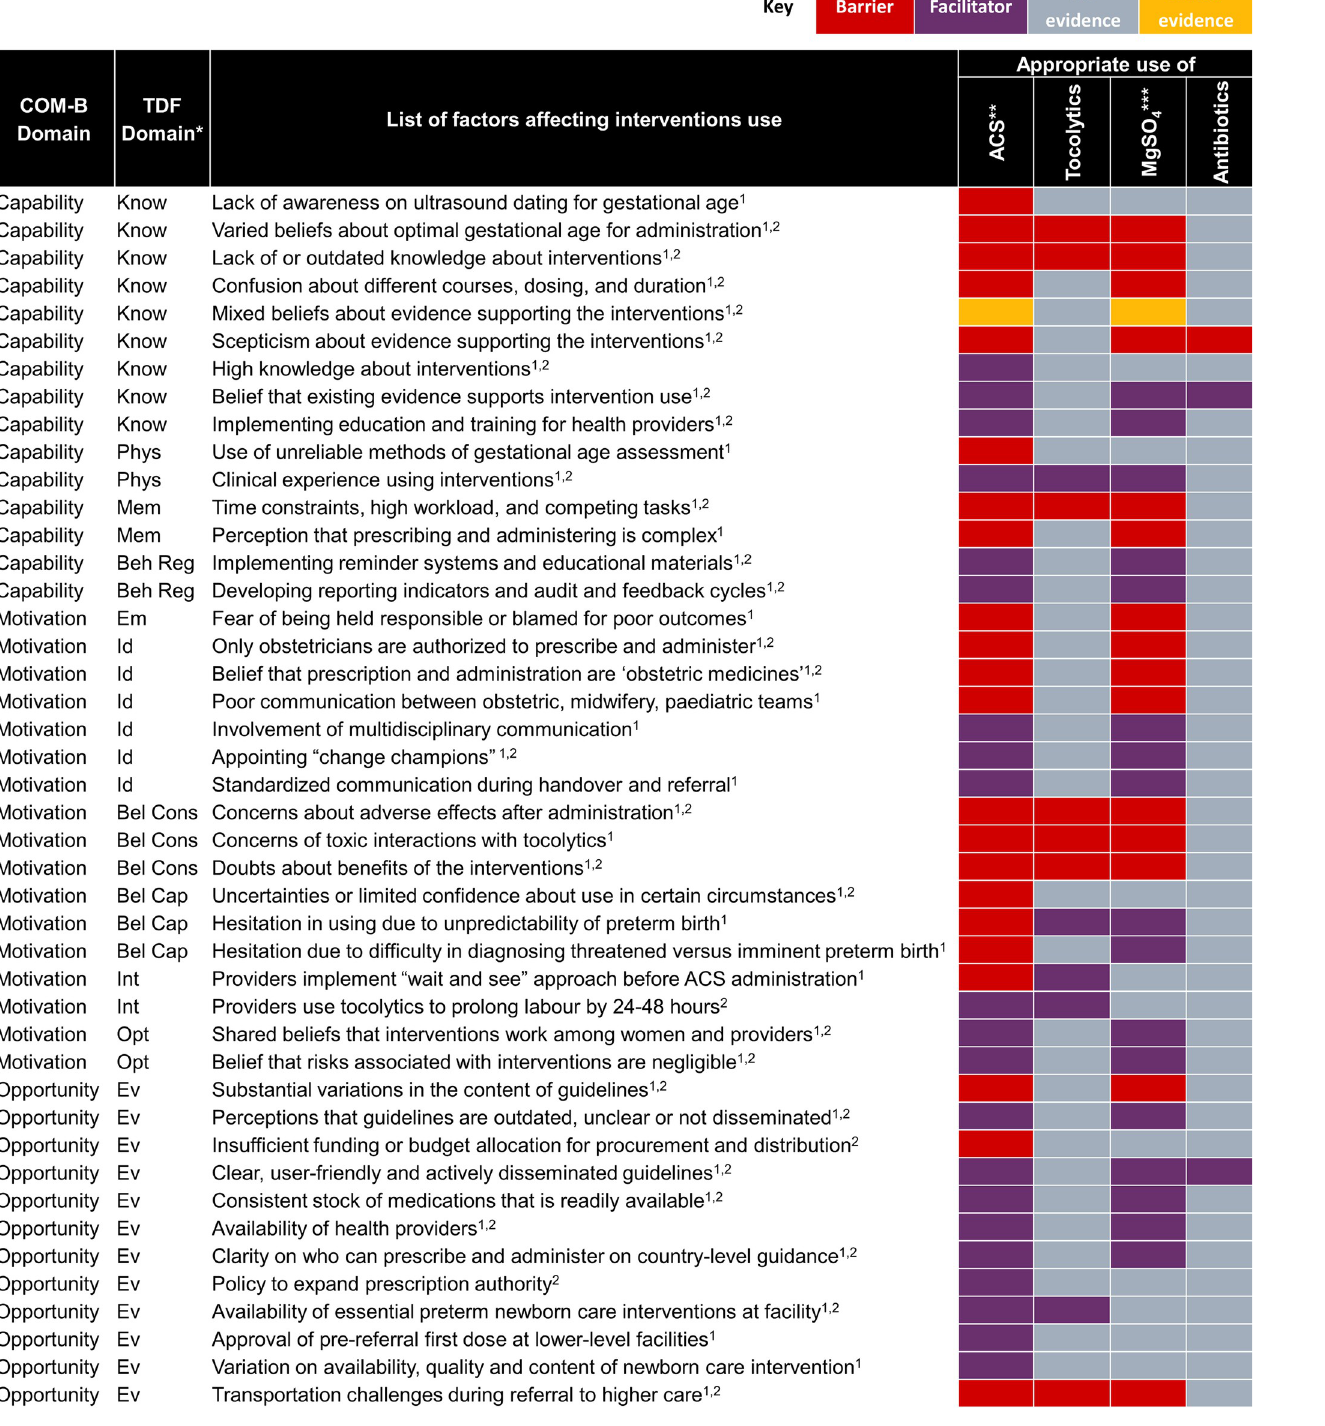
Fig 3. TDF and COM-B mapping of factors affecting appropriate use of ACS, tocolytics, magnesium sulphate, and antibiotics by health providers. � Know, Knowledge; Phys, Physical skills; Mem, Memory, attention, and decision processes; Beh Reg, Behavioural regulation; Em, Emotion; Id, Social/ professional role and identity; Bel Cons, Belief about consequences; Bel Cap, Belief about capabilities; Int, Intentions; Opt, Optimisms; Ev, Environmental context and resources. �� ACS; ��� Magnesium sulphate. 1 Factor identified from qualitative evidence. 2 Factor identified from quantitative evidence.